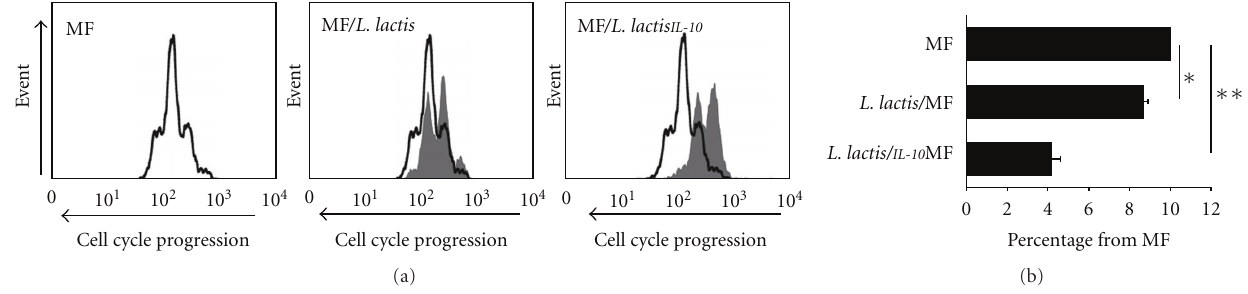
Figure 1: (a) Immature DC were matured with no bacteria, 1 × 10 5 cfu of viable L. lactis IL - 10 or L. lactis in the presence of MF. Mature DC were subsequently cultured with na¨ıve Th-cells to induce e ff ector Th-cells which were harvested, washed, and stained with 3 × 10 − 5 M PKH-26, a red cell-cycle tracking dye. Then, 2.5 × 10 4 e ff ector Th-cells were preactivated overnight with anti-CD3 (1:5000) and anti- CD28 (0.5 mg/mL) in round-bottom 96-well plates. The following day allogenic (CD4 + ) Th-cells were labeled with CFSE, a green cell-cycle tracking dye. After 5 days, the cellular content of CFSE in the allogenic Th-cells was analyzed by flow cytometry [13]. Depicted is the cell cycle progression of allogenic Th-cells stimulated in the presence of MF derived e ff ector Th-cells (white histograms, reference condition) and of allogenic Th-cells cultured in the presence of MF/ L. lactis IL - 10 or MF/ L. lactis derived e ff ector Th-cells (gray histograms). (b) Depicted is the mean inhibition of fluorescence intensity of allogenic Th-cells from five separate experiments for the indicated conditions. The proliferation of allogenic Th-cells cultured in the presence of e ff ector Th-cells derived from MF-matured DC which is regarded as 100% (reference condition). Mean percentages with standard error of mean are given; ∗ indicates P < 0 . 05 and ∗∗ indicates P < 0 . 01 using the χ 2 -test for comparing percentages with the reference condition